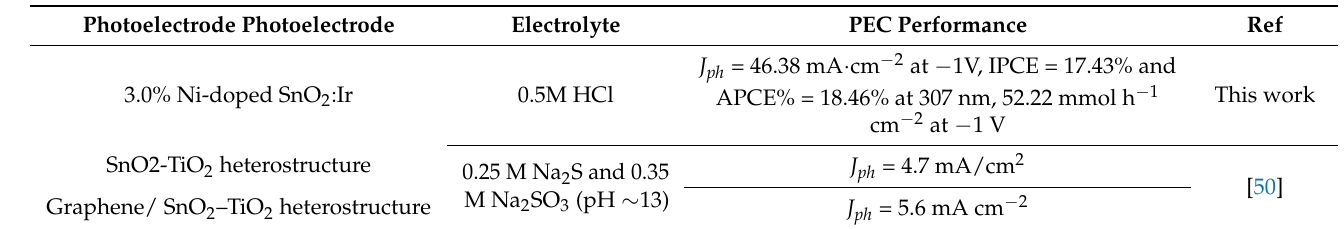
Table 2. Values of J ph and conversion efficiency of the optimized 3.0% Ni/IrSnO 2 photoelectrode relative to the previously reported SnO 2 -based PEC electrodes for H 2 O